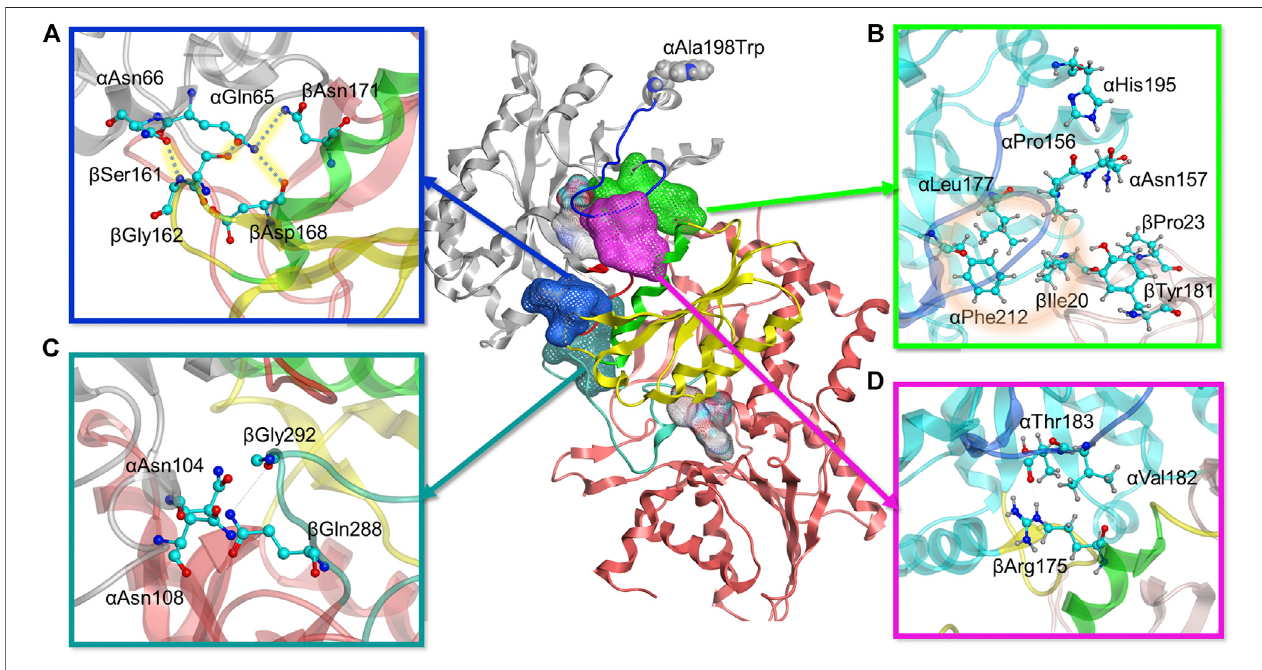
FIGURE 6 | Molecular modeling reveals four positions with stronger interdomain interactions in A198W TS. (A) Electrostatic link between alpha residues α Gln65, α Asn66andbetaresidues β Ser161, β Gly162, β Asp168,and β Asn171(alsosee SupplementaryFigure11 ). (B) Hydrophobicclusterbetween α Leu177, α Phe212,and β Ile20observedinA198WTS(alsosee SupplementaryFigure9 ). (C) α Asn104formsconsistenthydrogenbondswith β Gln288/ β Gly292inA198WTS (D) Consistent hydrogen bond between α Thr183 and α Arg175 may contribute to closed α L6 conformation (also see Supplementary 11A